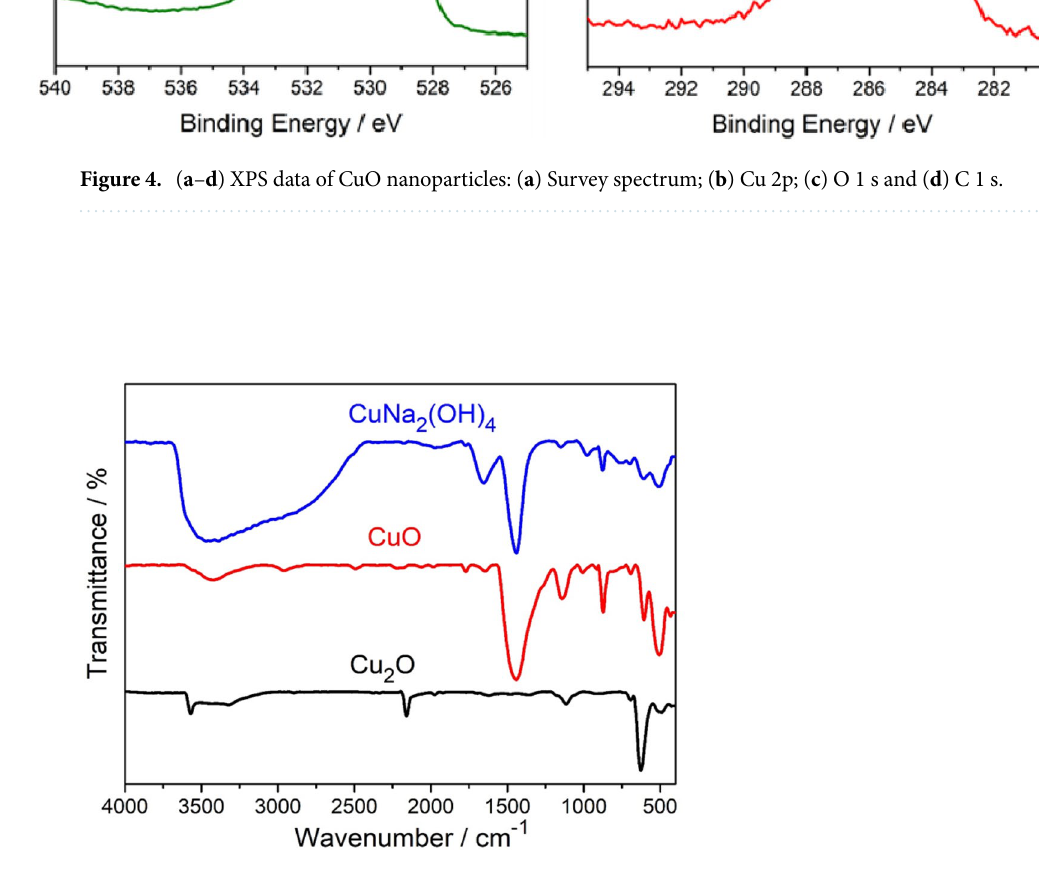
Figure 5. FT-IR spectra of Cu 2 O, CuO and CuNa 2 (OH) 4